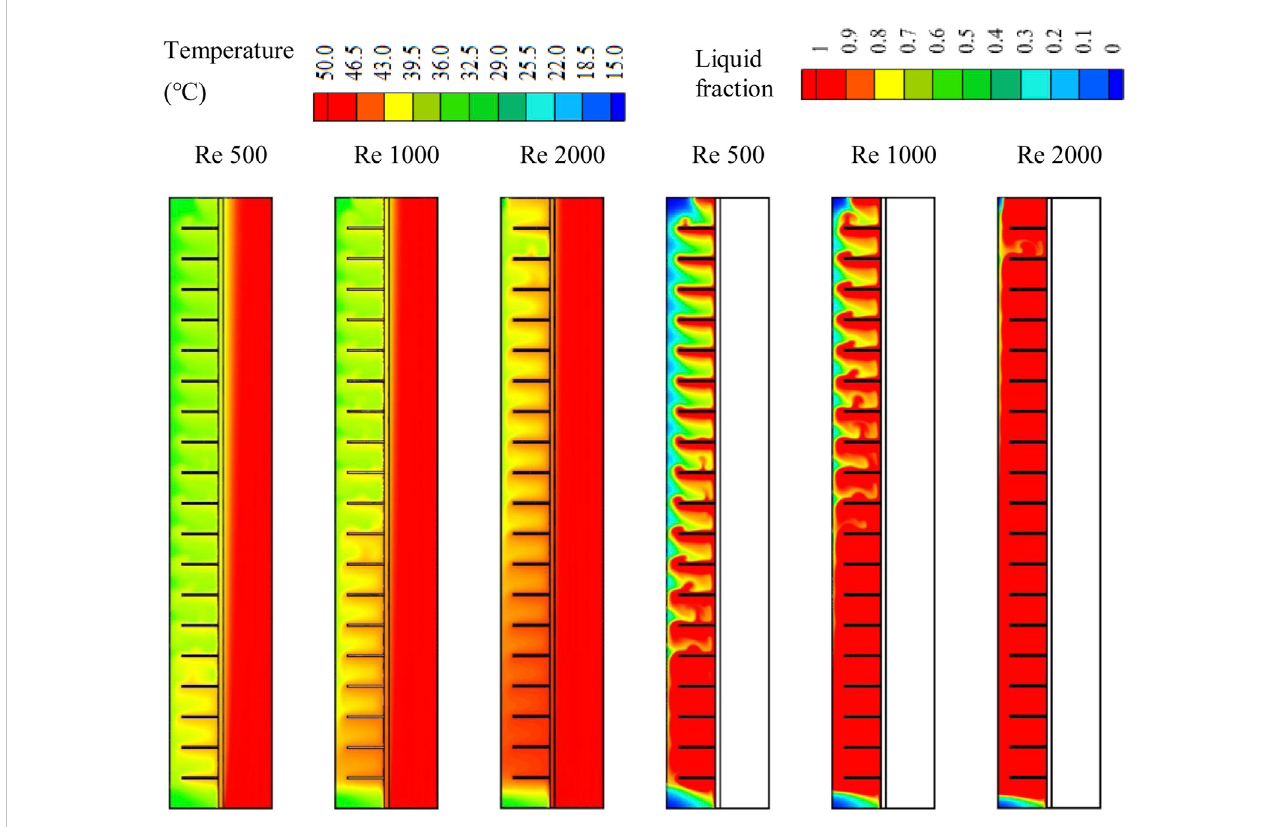
FIGURE 12 The melting process and temperature distribution of the PCM with different Reynolds number (Re) at 3,600